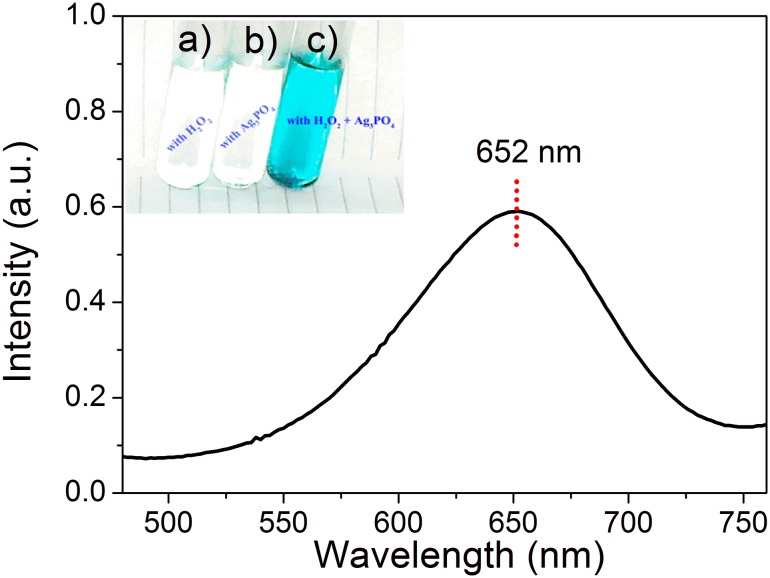
UV-vis spectrum of the reaction system with H2O2 + Ag3PO4 nanocrystals.The inset shows images of oxidation color reaction of TMB in NaAc buffer with a) H2O2, b) Ag3PO4 nanocrystals and c) H2O2 + Ag3PO4 nanocrystals. Reaction conditions: 0.3 mM of TMB, 2 mg/mL of Ag3PO4 (if with), 3.6 mM of H2O2 (if with) in 5 mL of NaAc buffer with pH 4.0. The reaction proceeded at 25°C with time of 30 min.